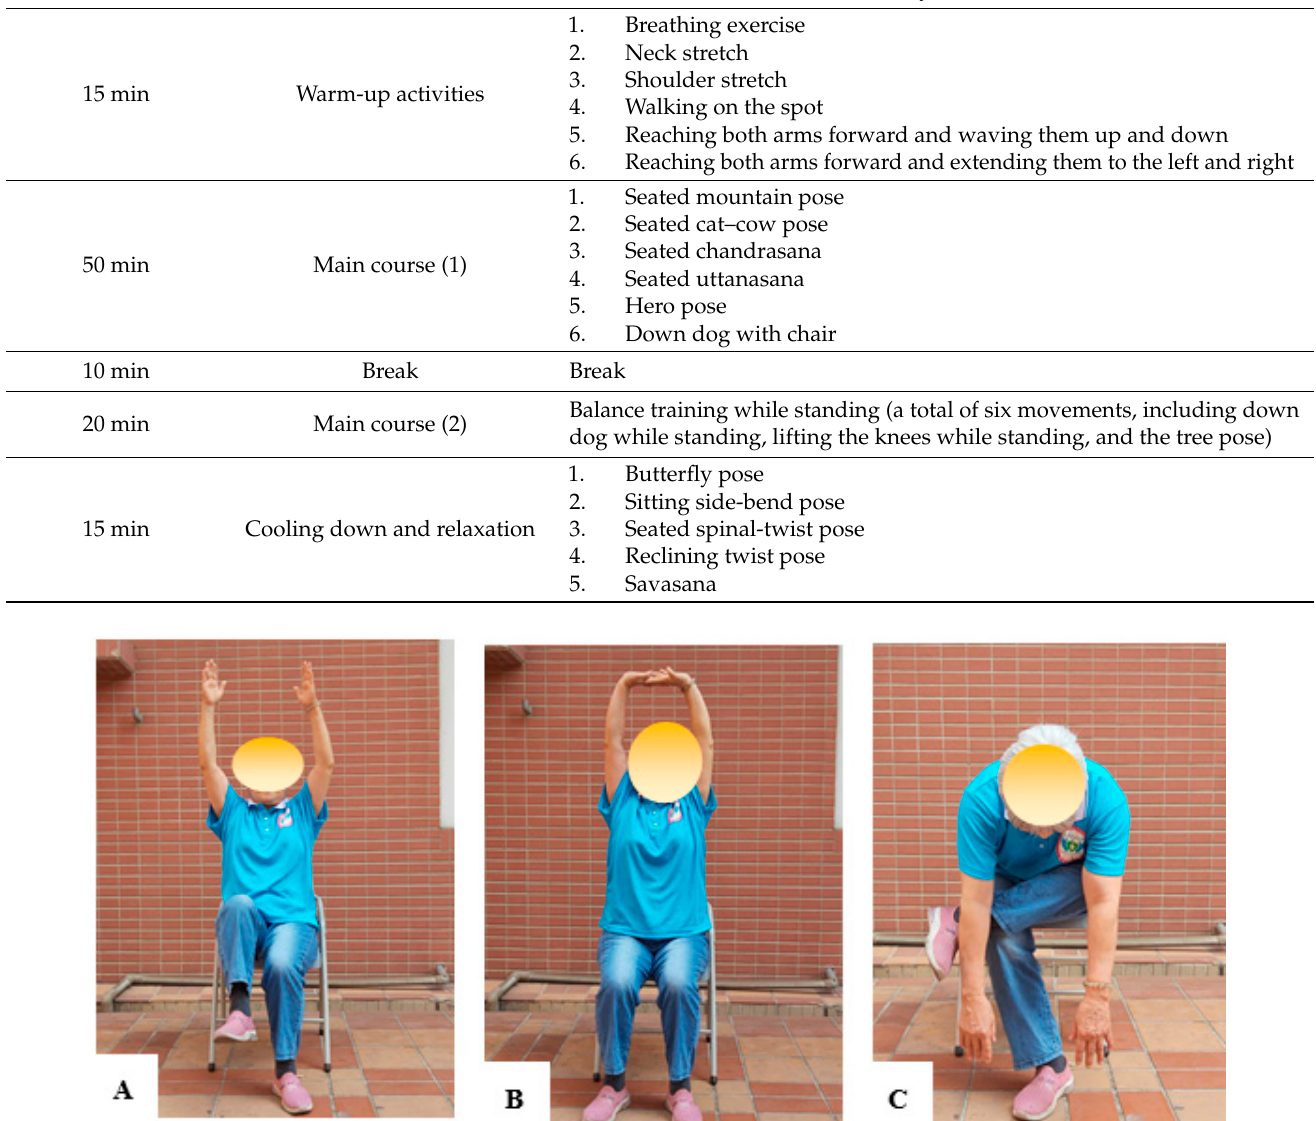
Table 1. Content of the chair yoga therapy activities.